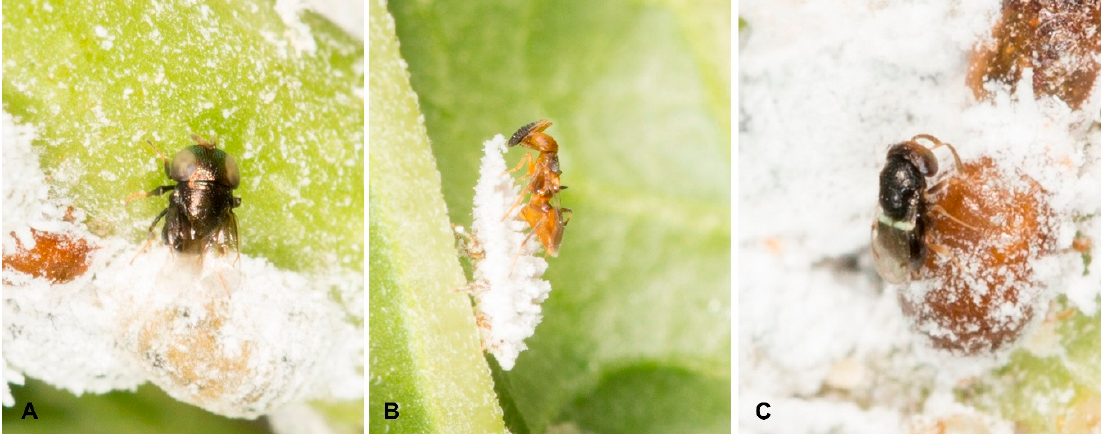
Figure 1. ( A ) Aenasius arizonensis parasitizing Phenacoccus solenopsis; ( B ) Cheiloneurus nankingensis parasitizing Phenacoccus solenopsis via probably Aenasius arizonensis; ( C ) Promuscidea unfasciativentris parasitizing a mummy of Phenacoccus solenopsis.